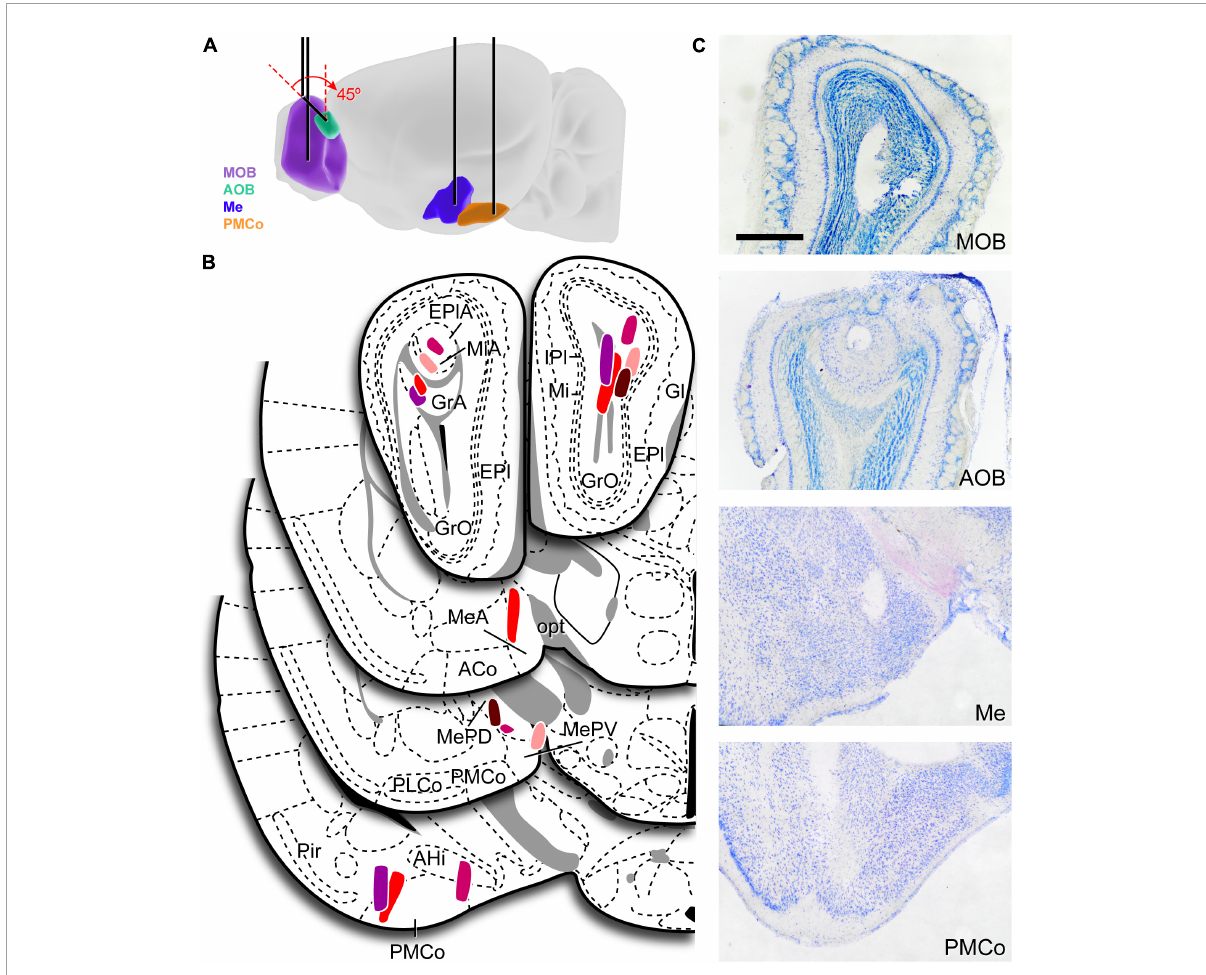
FIGURE1 Electrodes implantation and verification. (A) Schematic diagram of the recording sites. Black lines represent the monopolar LFP electrodes. (B) Schematic drawings of the recording region on all valid cases, each color indicates a different animal ( n = 5). The number of valid electrodes in each structure is: MOB, n = 5; AOB, n = 4; Me, n = 4; PMCo, n = 4. One electrode in the PMCo was located in its caudal part (not shown). (C) Histological verification of the electrodes position, the actual recording site (electrode tip) should be along the observed trace. ACo,